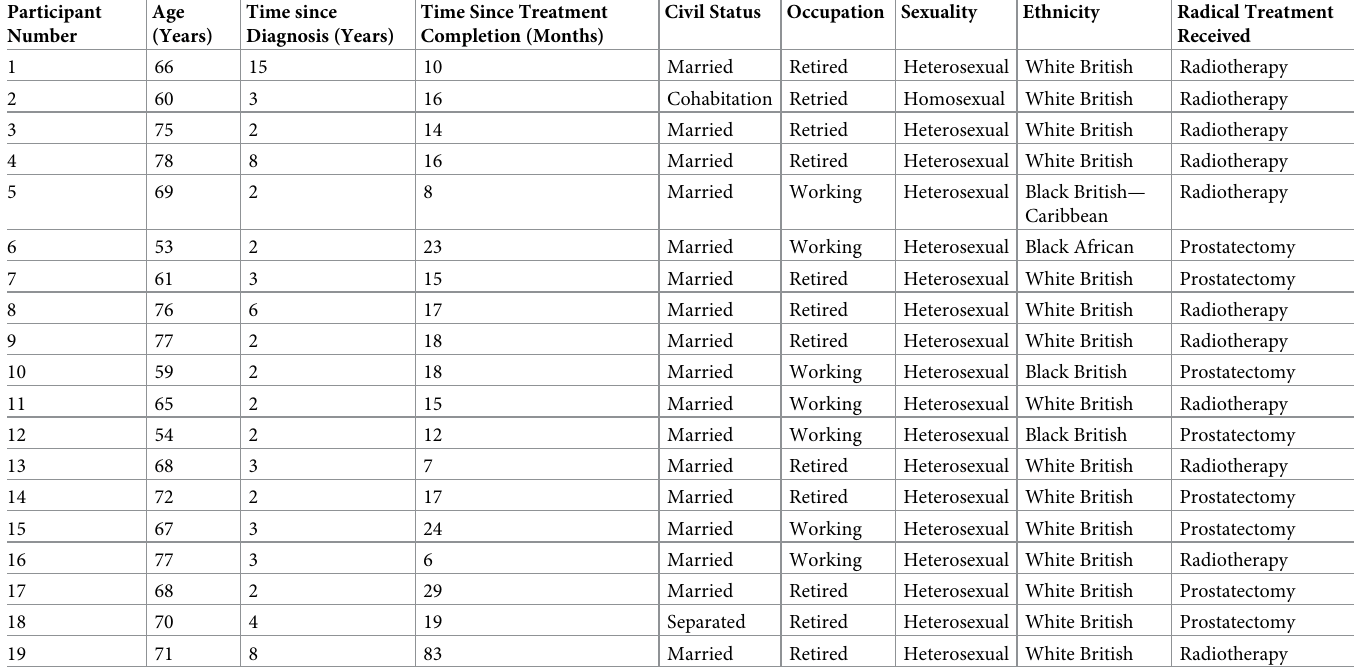
Table 1. Participant